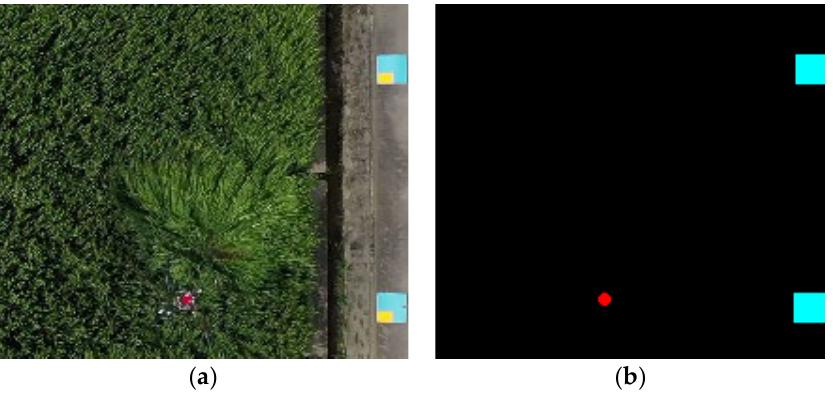
Figure 4. Identification of colors in images. ( a ) Original image. ( b ) Recognition result.